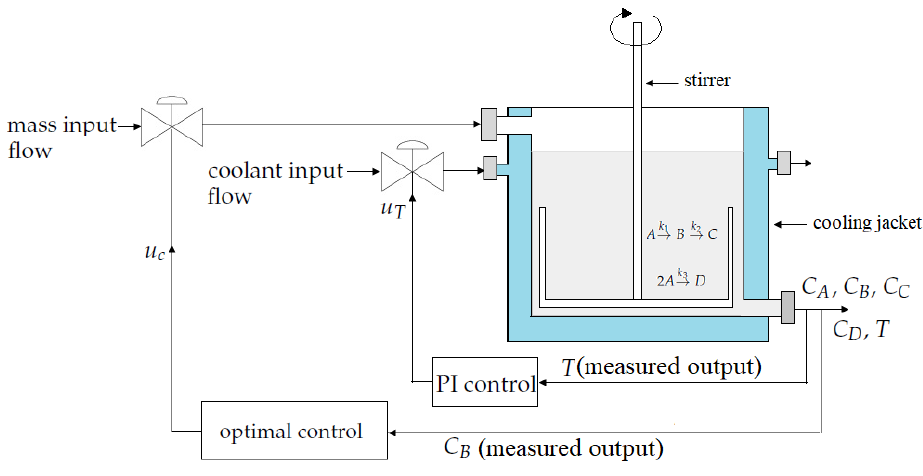
Figure 1. Exothermic